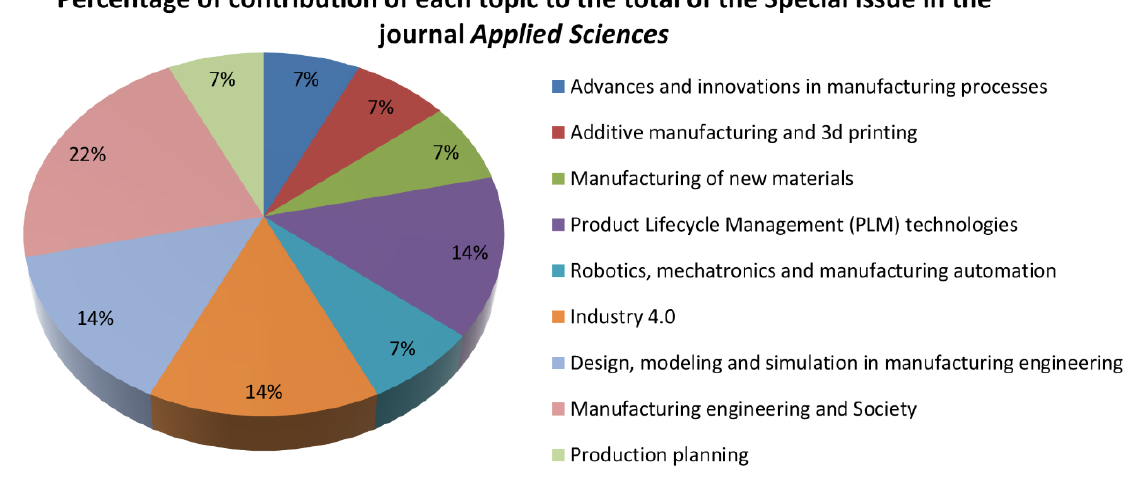
Figure 2. Percentage of contribution of each topic to the Special Issue in the journal Applied Sciences.